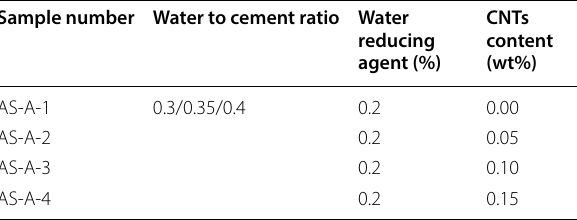
Table 5 Mixture proportions of different cement pastes with